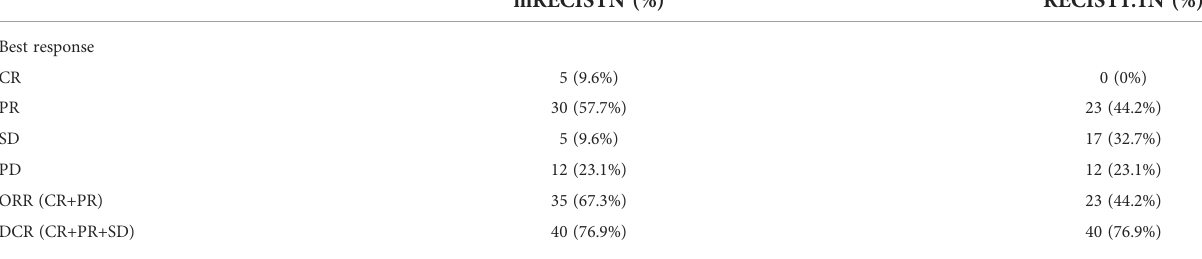
TABLE 2 Radiological response according to mRECIST and